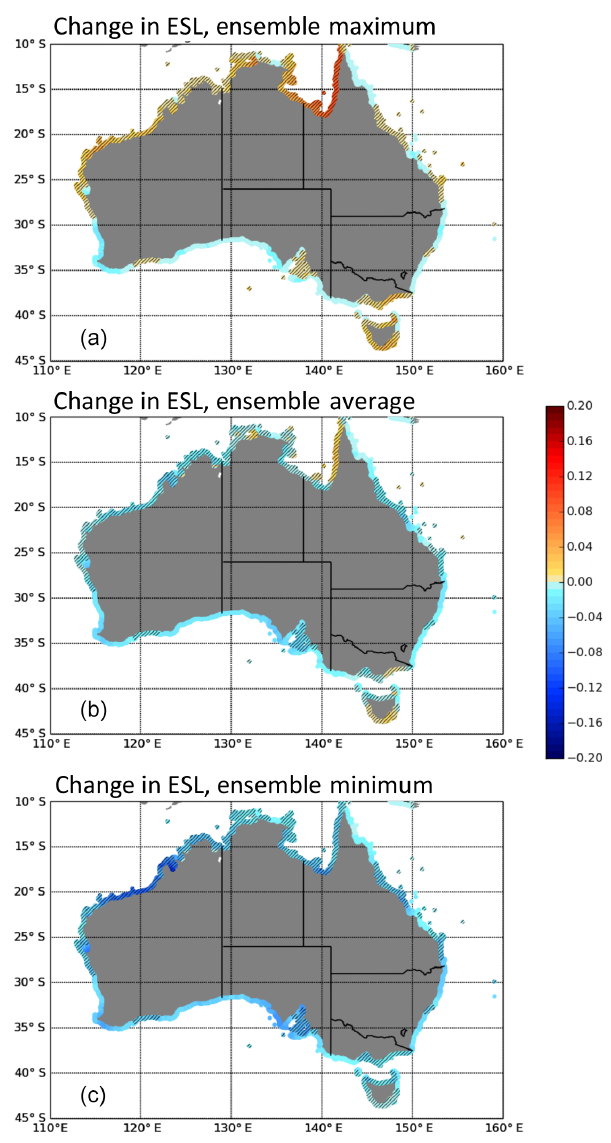
Figure 11. Projected change in the 1-in-20-year average return in- terval (ARI) extreme sea level (residuals) for the model ensemble. (a) Ensemble minimum. (b) Ensemble average. (c) Ensemble max- imum. Hatched areas indicate where models disagree on sign. Units are in